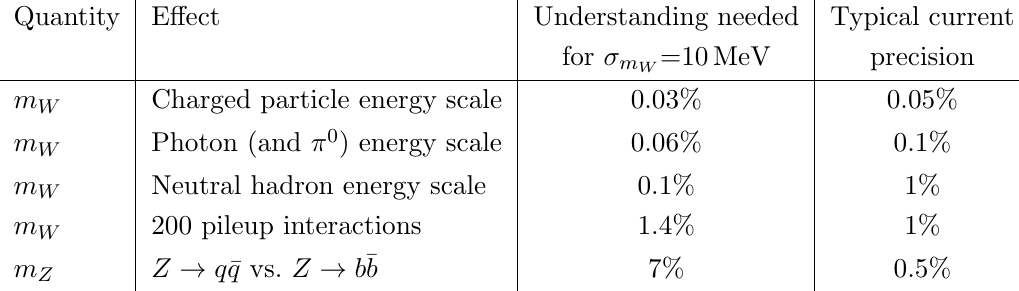
Table 4 . List of systematic e(cid:11)ects. Unless stated otherwise a selection of p T > 300 GeV and Experimental systematic uncertainties are estimated using detector